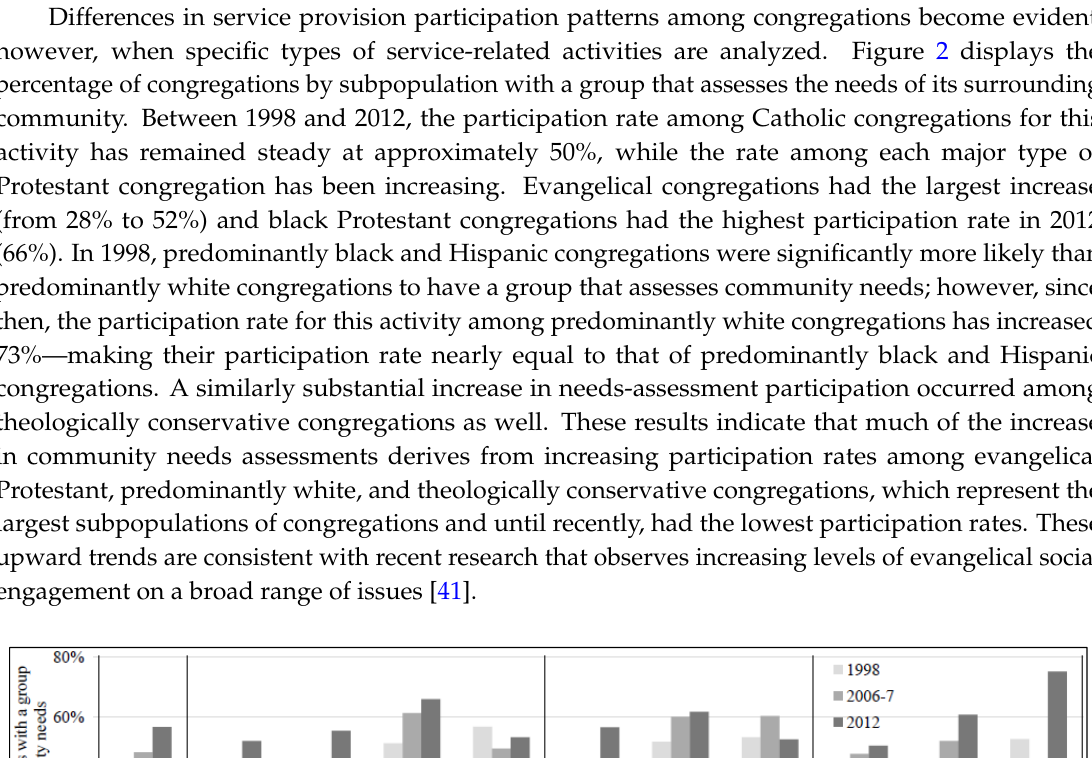
Figure 1. The percentage of congregations by subpopulation involved in at least one type of service-related activity by wave.